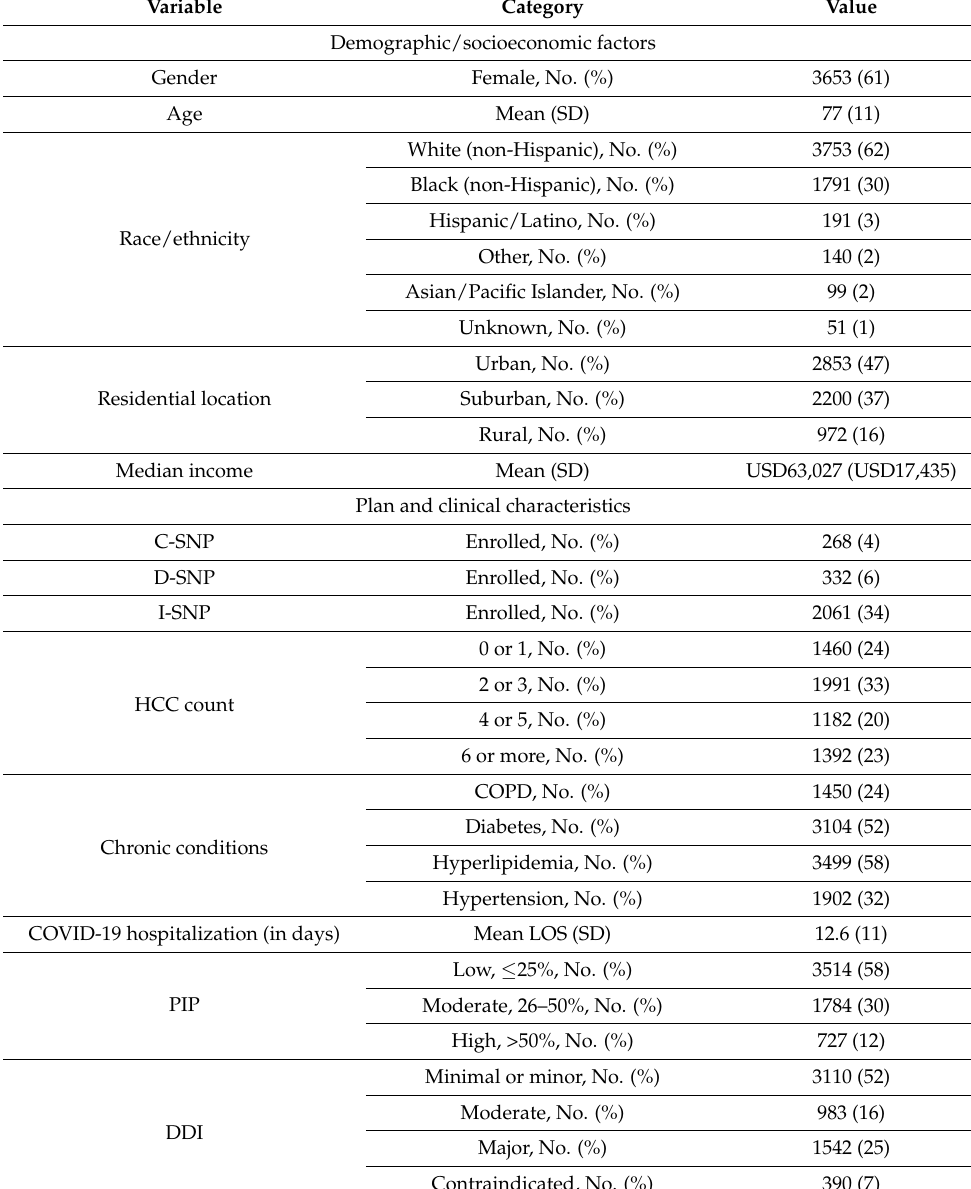
Table 1. Characteristics of hospitalized COVID-19 Medicare Advantage